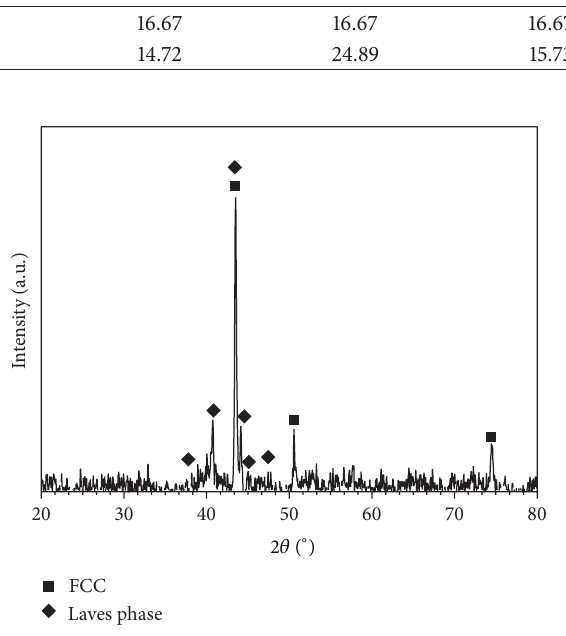
Figure 2: XRD pattern of CoCrFeMnNbNi HEA